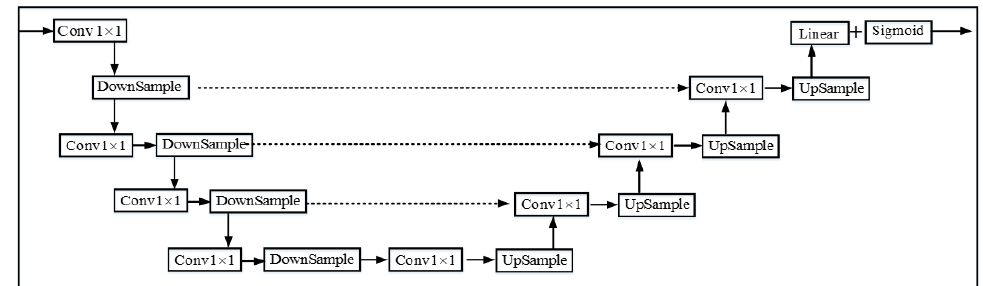
Figure 4. MLCNN network structure.